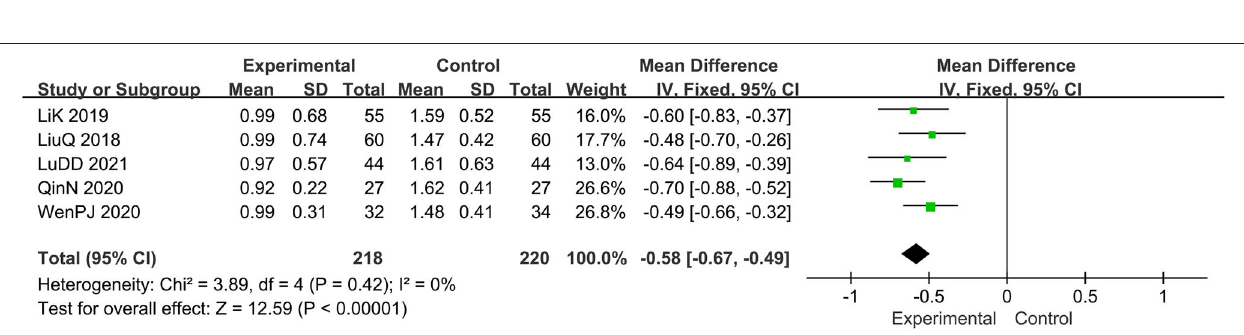
FIGURE 8 | The meta-analysis for comparison of combination therapy vs. prednisone for the outcome of the score of erythema symptoms.